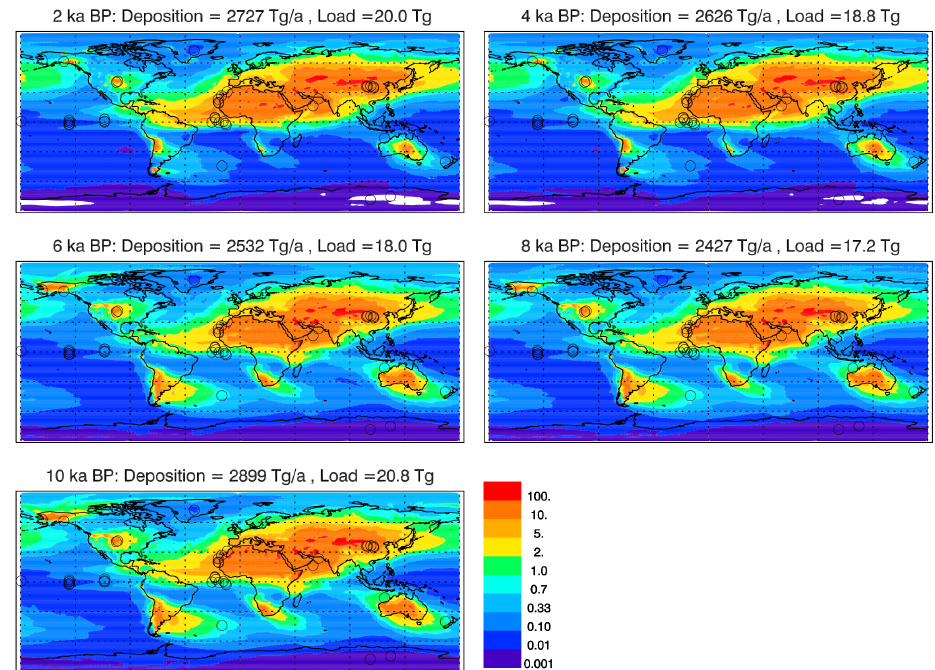
Figure 17. Dust deposition flux (gm − 2 a − 1 ) from the CESM during the Holocene snapshots at 2, 4, 6, 8, and 10kaBP, based on spatially variable emissions constrained by the observational mass accumulation rates. Black circles mark the locations of the observational records in this